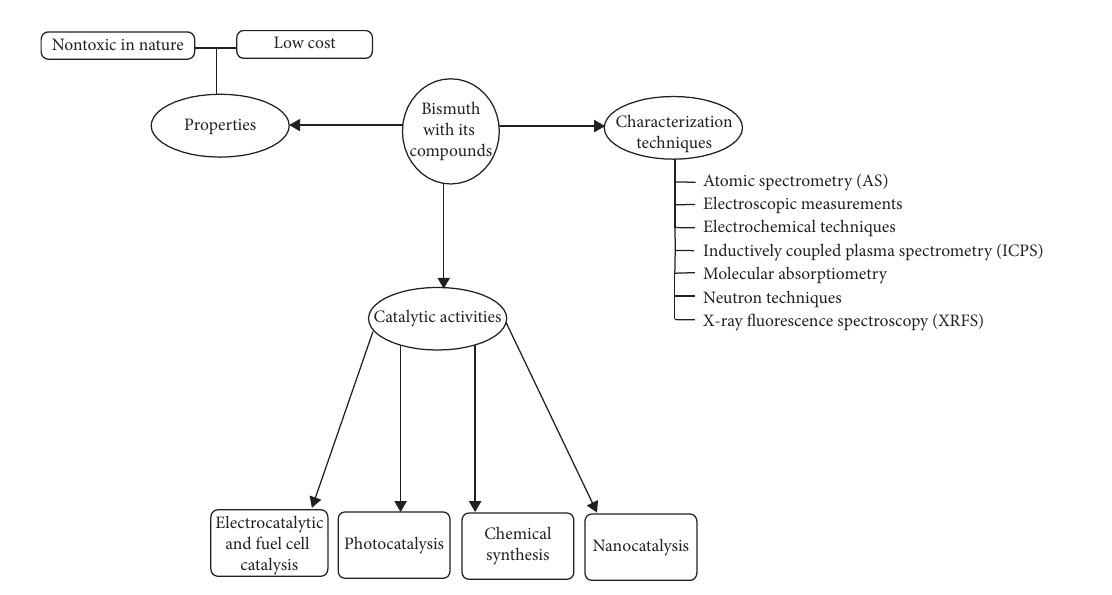
Figure 2: Bismuth catalytic